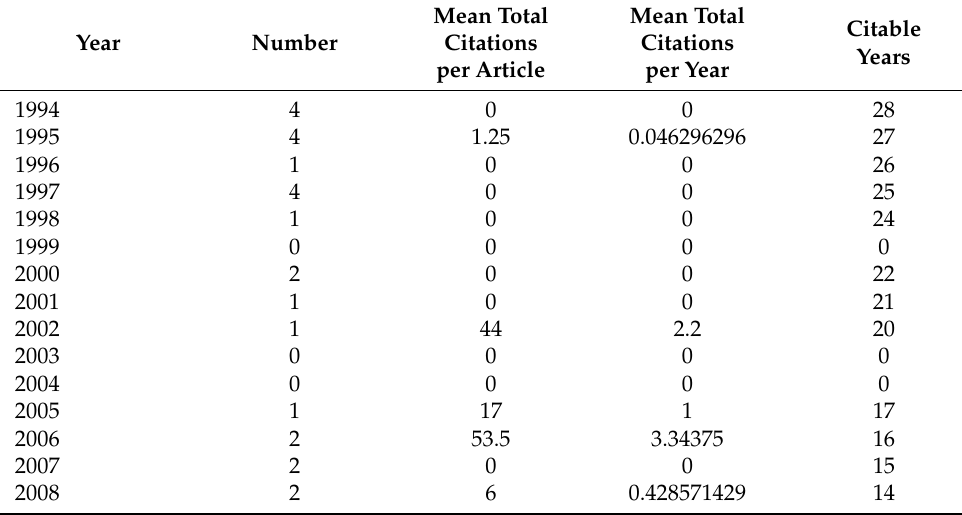
Figure 9. Historical Direct Citation Network. Table 7. Citations trends, total and per year.